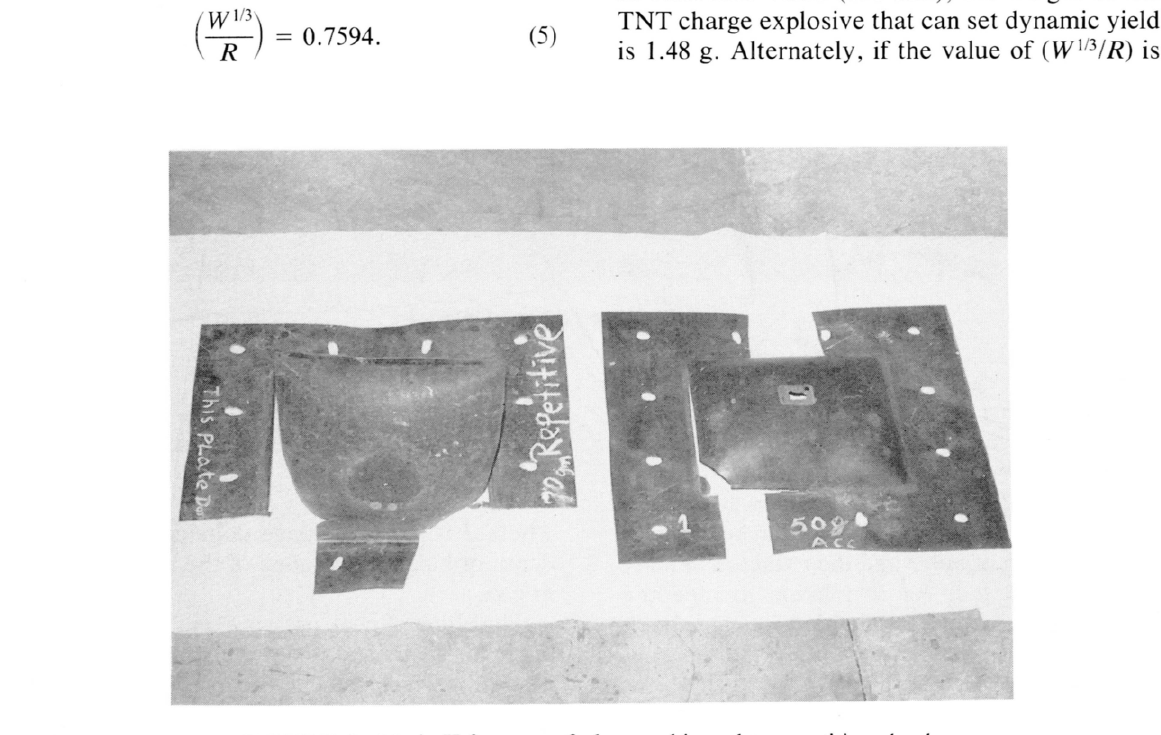
FIGURE 6 Mode-II fracture of plates subjected to repetitive